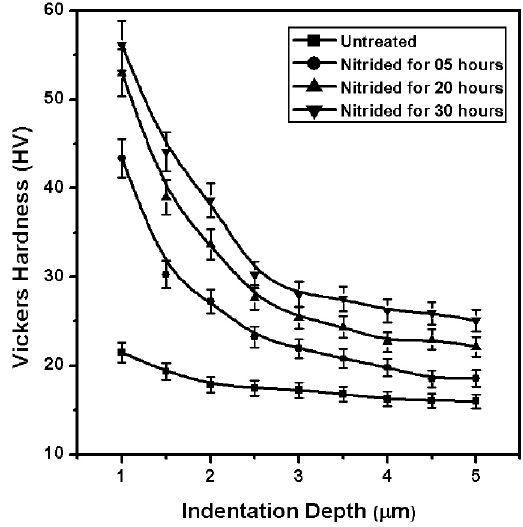
Figure 5. Variation of Vickers hardness as a function of indentation depth of samples nitrided for different times (15, 21 and 30 hours), at fill pressure of 0.5 mbar.